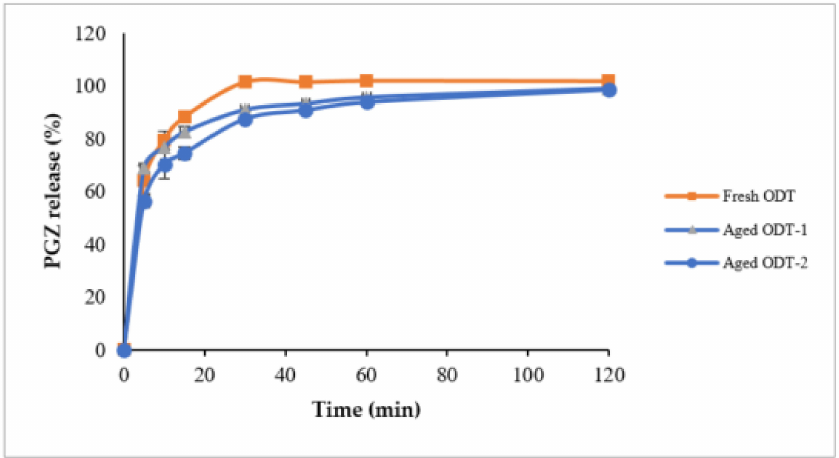
Figure 12. In vitro dissolution profile of Pioglitazone HCl from aged ODT tablets at accelerated stor- age condition; Aged ODT-1 at 25 ± 2 ◦ C, 60 ± 5%; Aged ODT-2 at 40 ± 2 ◦ C, 75 ± 5%. Abbreviations: ODT, orally disintegrating tablet; PGZ, Pioglitazone